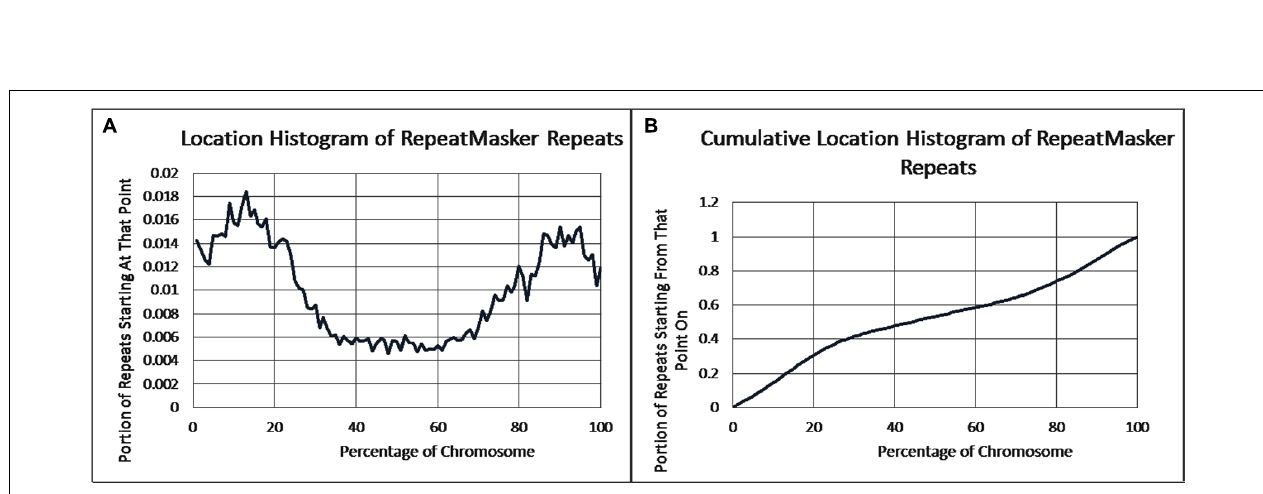
FIGURE 2 | Repeat locations. (A) The fraction of repeats starting at each percent point of their chromosomes on average, as identified by RepeatMasker. (B) The cumulative probability distributions of repeats on average. For each percentage point the fraction of clones starting at that point or further is given.